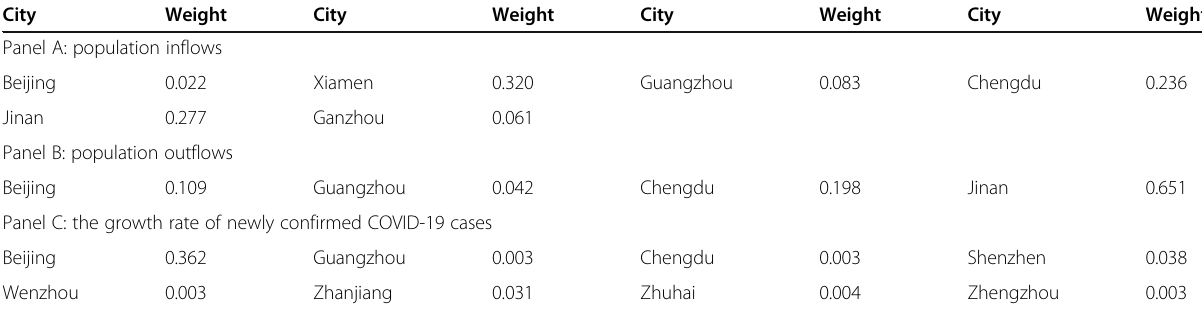
Table 2 City weights in the synthetic Wuhan City